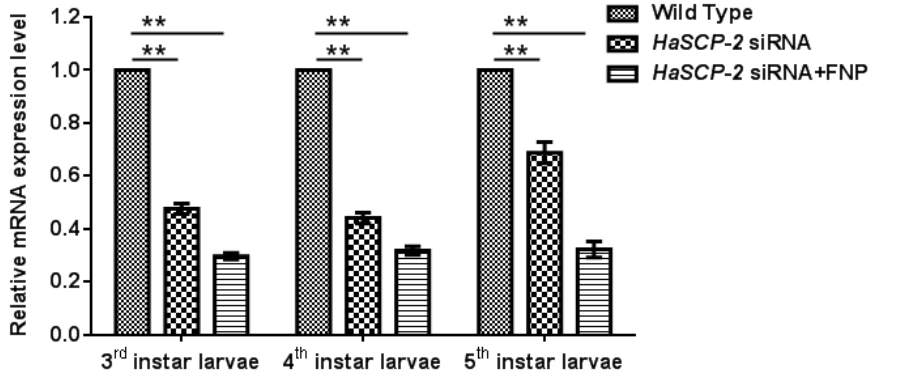
Figure 6. HaSCP ‐ 2 expression level in the midgut of H. armigera by FNP ‐ RNAi in vivo . Ten 2nd in ‐ star larvae were synchronized as a group and fed with FNP ‐ HaSCP ‐ 2 siRNA ( HaSCP ‐ 2 siRNA + FNP group). Midgut tissues from five individual larvae at 3rd, 4th, and 5th instar larvae, respec ‐ tively, were collected, and the relative HaSCP ‐ 2 mRNA expression levels in the larval midgut were determined by qRT ‐ PCR. The 2nd instar larvae were fed with HaSCP ‐ 2 siRNA and DEPC ‐ treated ddH 2 O (Wild Type group), respectively, were used as the control. Data are mean ± SD. Asterisk “**” indicates significance at p < 0.01 level.